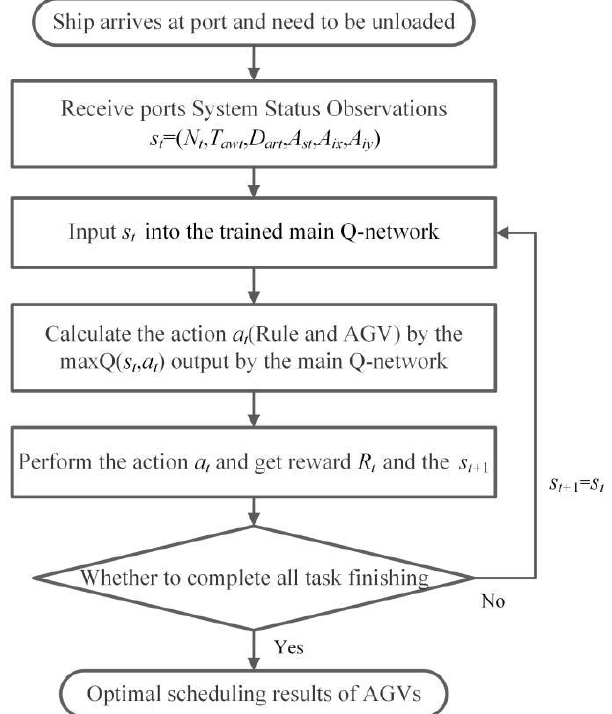
Figure 4. Optimal mixed rule scheduling of automated terminal AGVs.